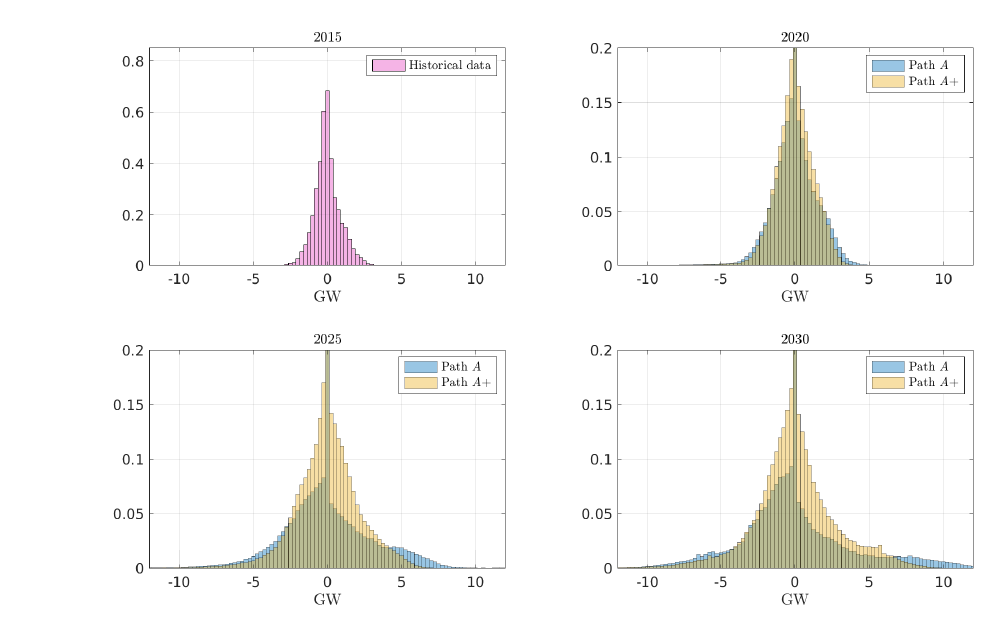
Figure 5. Histograms of hourly hydropower gradients normalised to probability density function. Top left: historical data (2015); rest of figures: results for transition paths A and A+